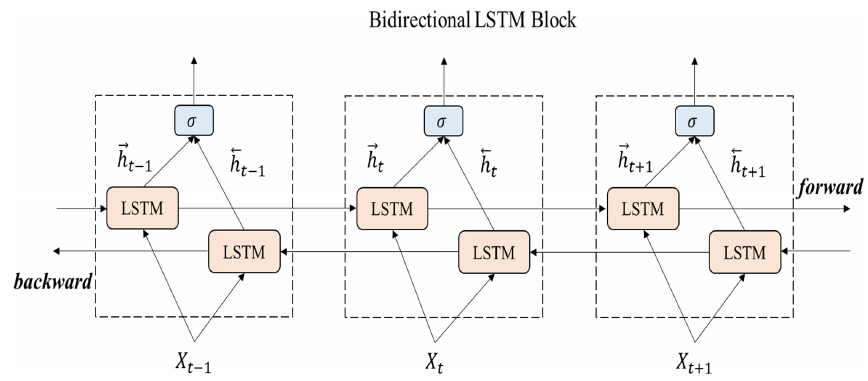
Figure 1. The bidirectional structure of the Bi-LSTM